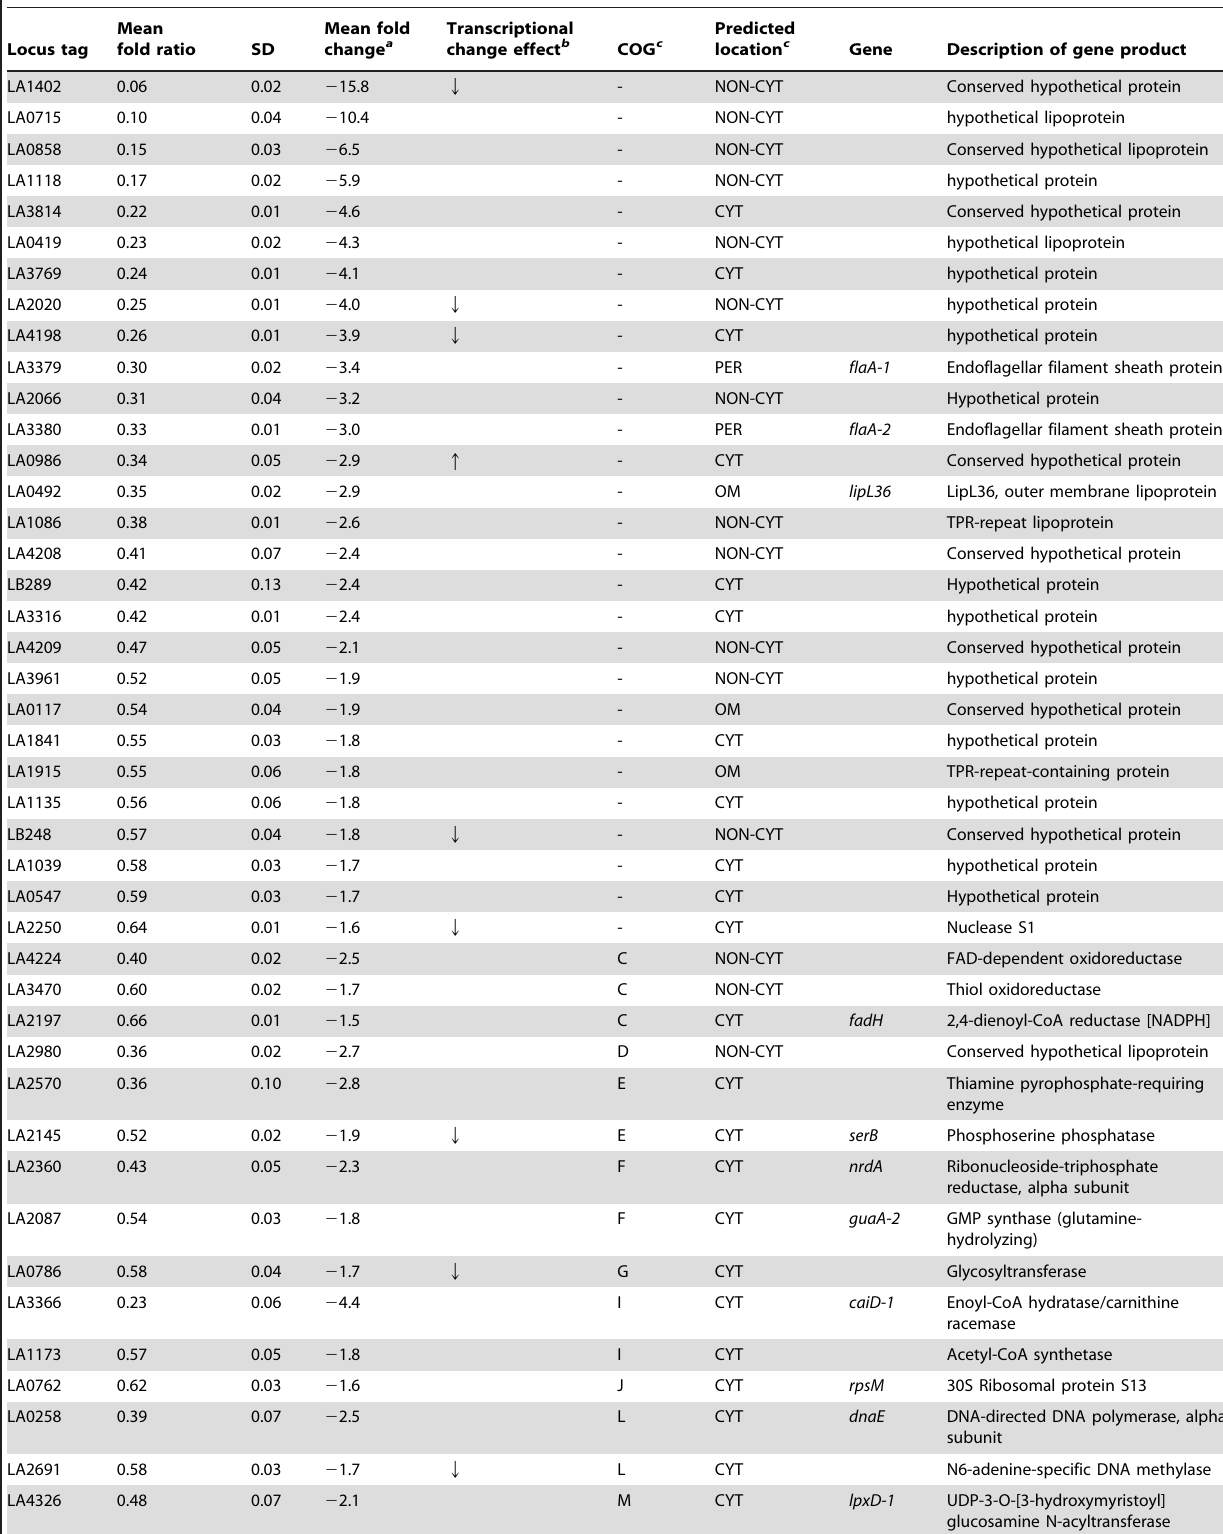
Table 3. Proteins which were at least 1.5-fold down-regulated at 37 u C upshift compared to 30 u C grouped by COG category. The COG category is shown for each protein. The change in transcription at 37 u C upshift versus 30 u C is shown for comparison with the proteomic